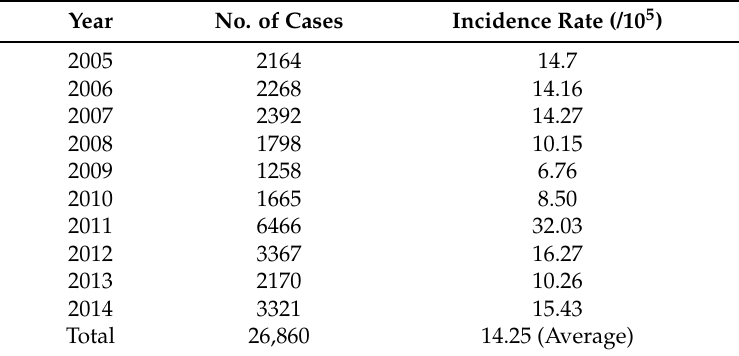
Table 1. Incidence of scarlet fever in Beijing from 2005 to